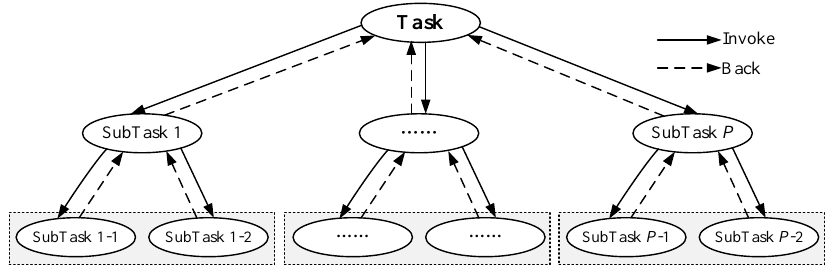
Figure 1. Map of the divide-and-conquer strategy.